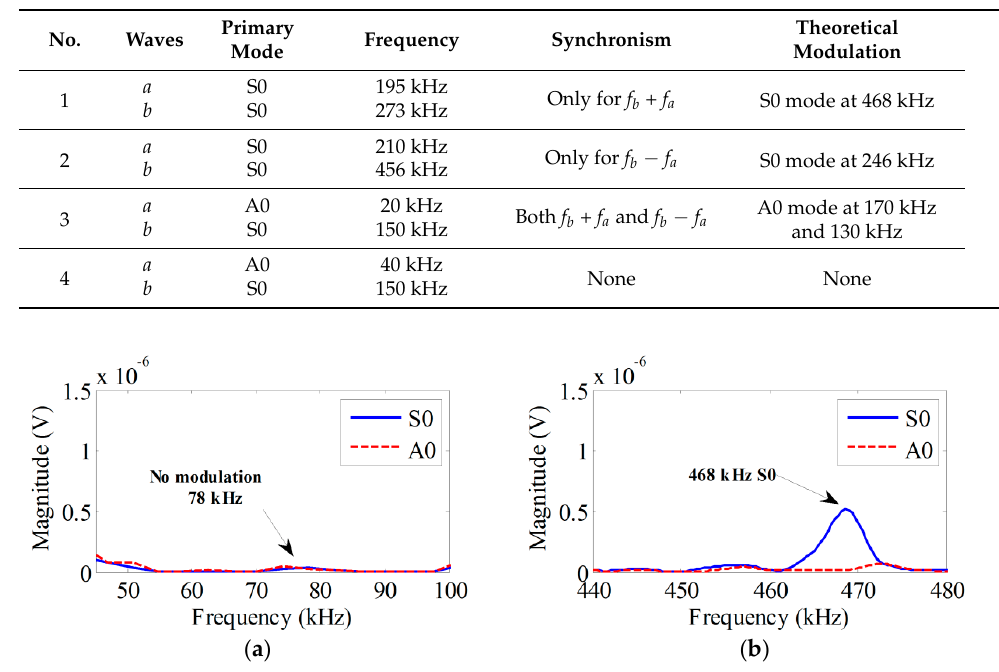
Table 3. Four pairs of primary mode for the demonstration.